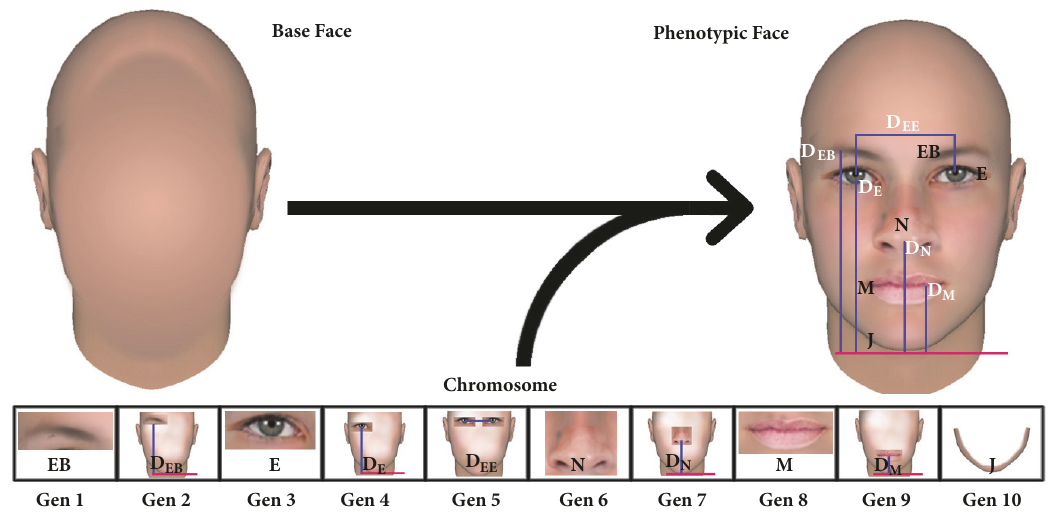
Figure 1: Structure of the chromosomes. A face is constructed by placing on the base face the features indicated by genes 1, 3, 6, 8, and 10, at the positions indicated by genes 2, 4, 5, 7, and